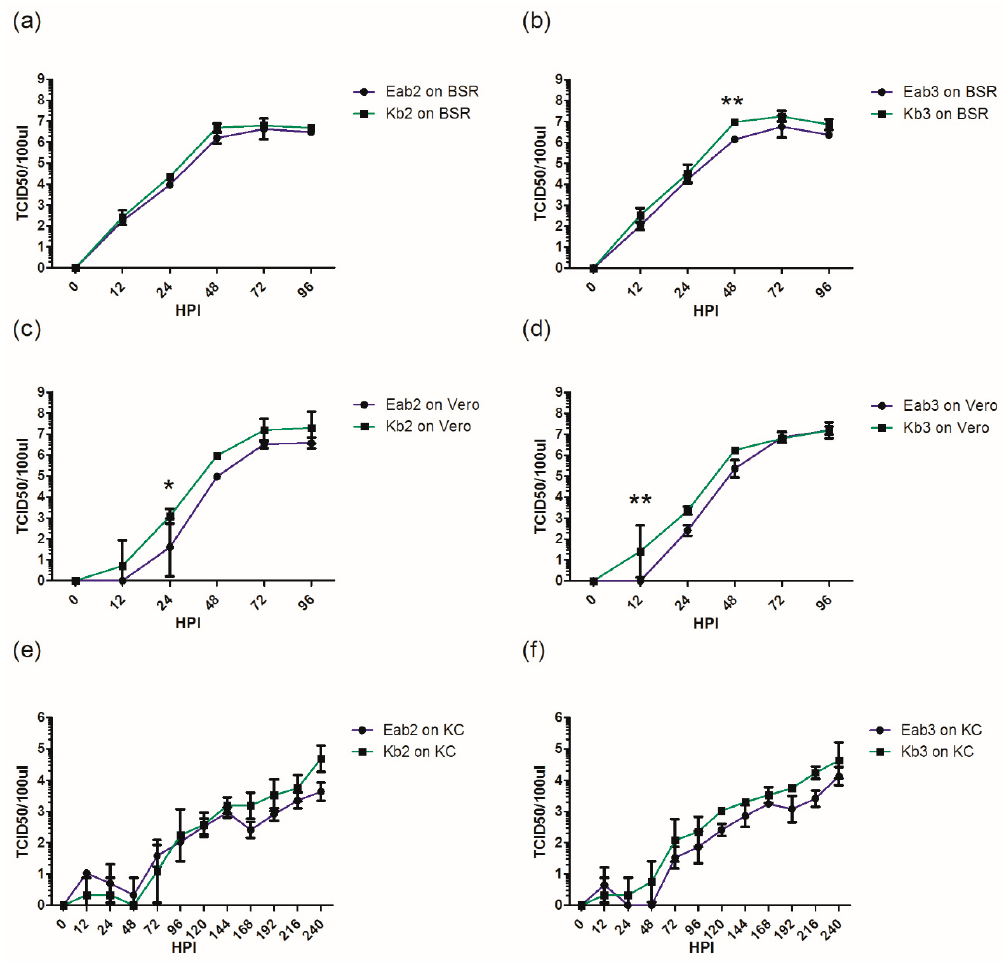
Figure 7. One-step growth analysis of second and third passaged BTV on mammalian baby hamster kidney cells (BHK-BSR) ( a , b ), Vero ( c , d ), or Culicoides -derived (KC) cells ( e , f ). Cells were infected at a multiplicity of infection (MOI) of 0.01 in triplicate. Supernatants were collected at 12 h, 24 h, and then every 24 h until 96 (BSR / Vero) or 240 (KC) h post infection (HPI) and then titrated in Vero cells using limiting dilution analysis. The error bars represent standard deviation. Statistical analysis was performed using ANOVA followed by Bonferroni multiple-comparison test. * p < 0.05, ** p < 0.01. Kb = KC/BHK-BSR; Eab = embryonated chicken egg (ECE)/ Aedes /BHK-BSR.